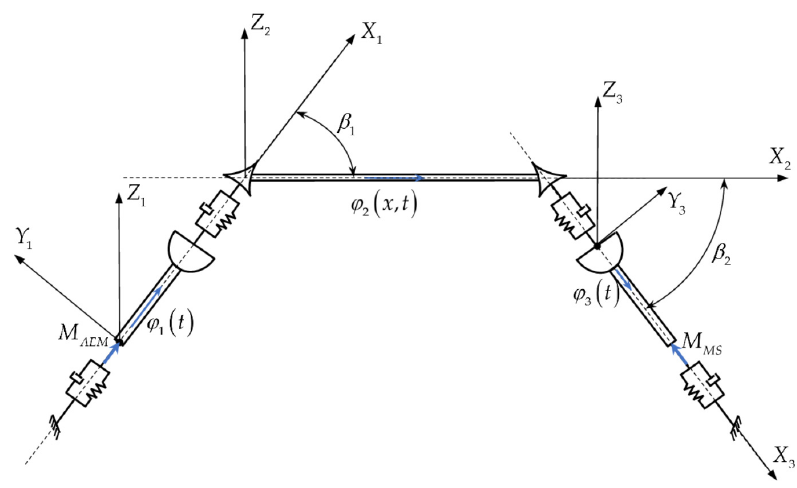
Figure 7. The general scheme of DTID.